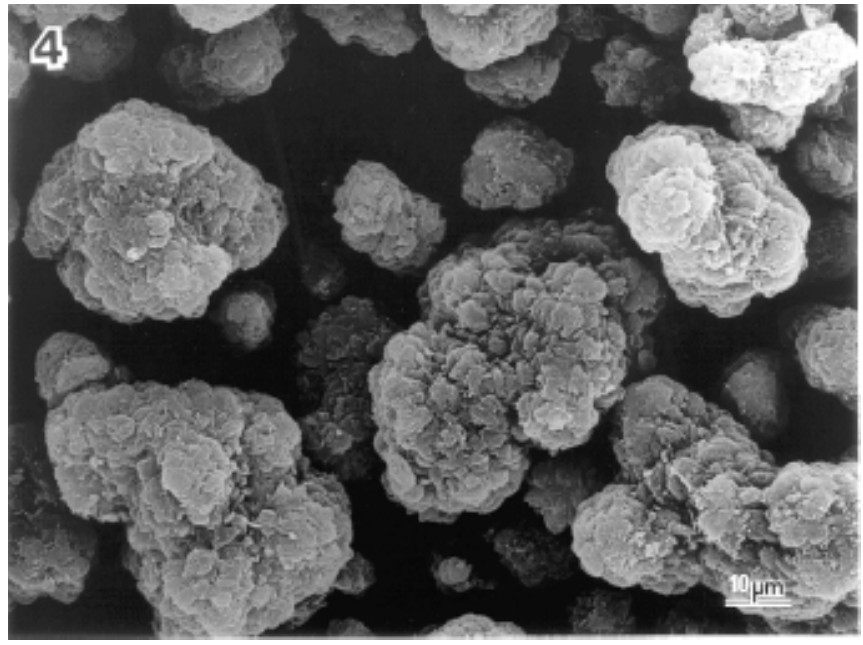
Fig. 4 – Scanning electron micrograph (SEM) of several crystalline particles